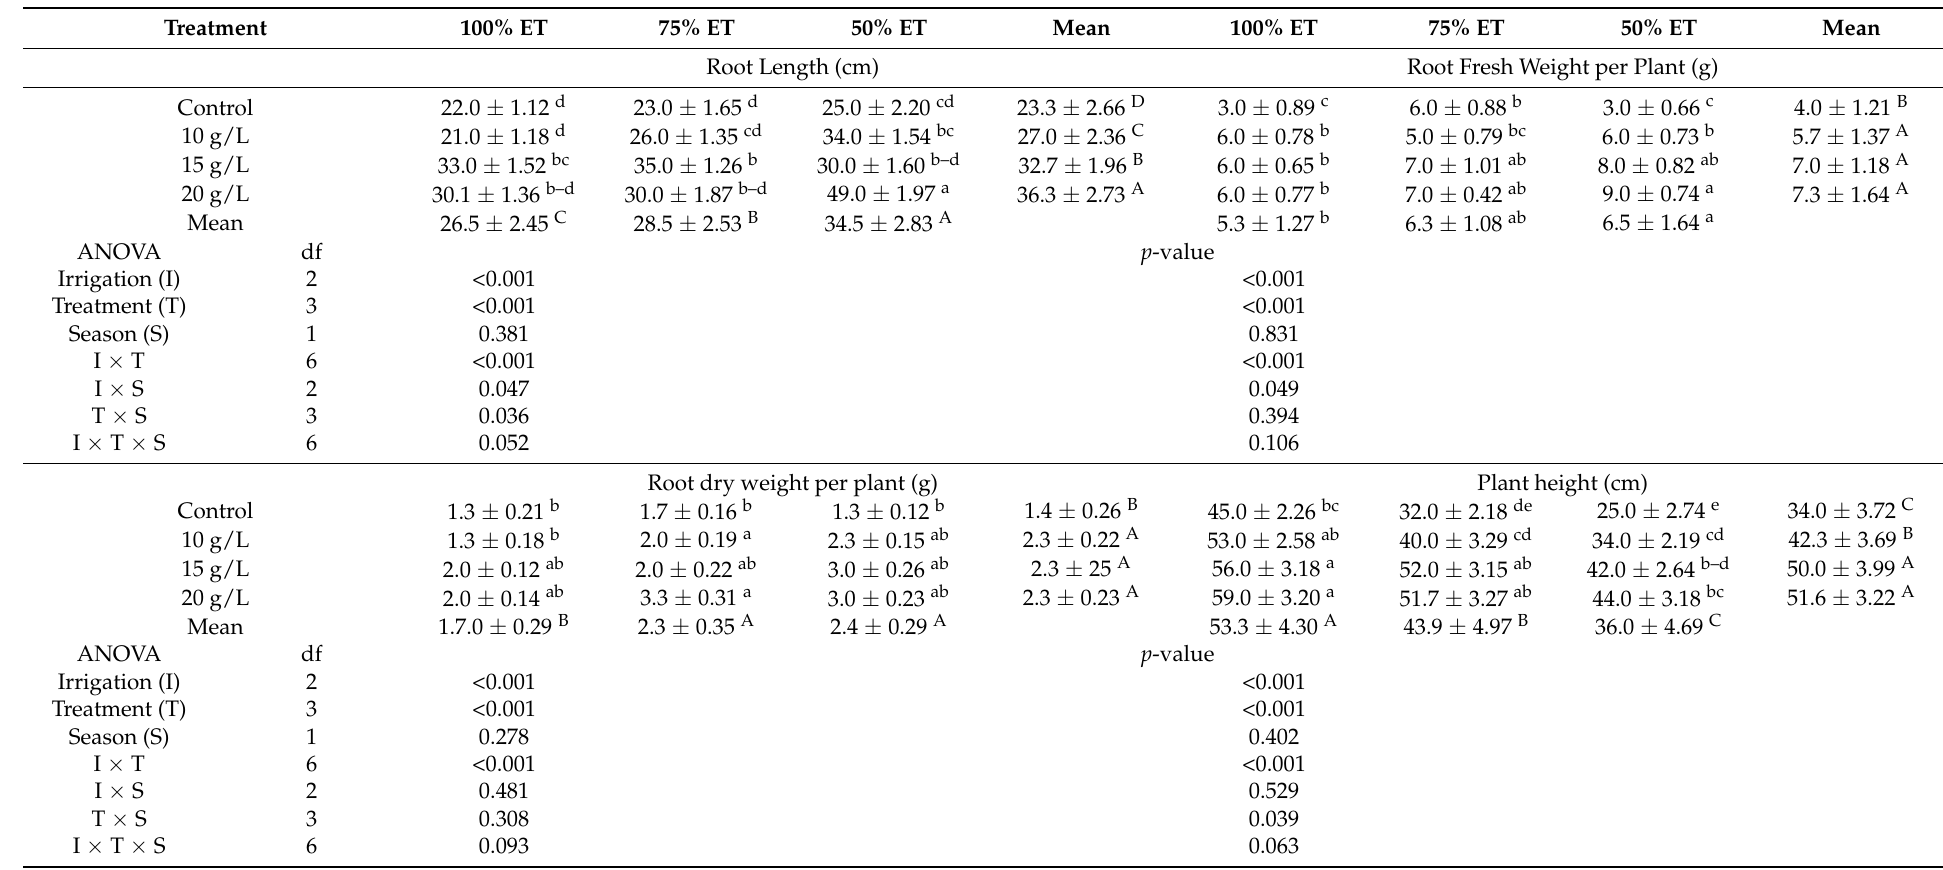
Table 4. Influence of potassium silicate on plant height, number of leaves per plant, fresh and dry weights of shoot/plant of squash plants under different irrigation